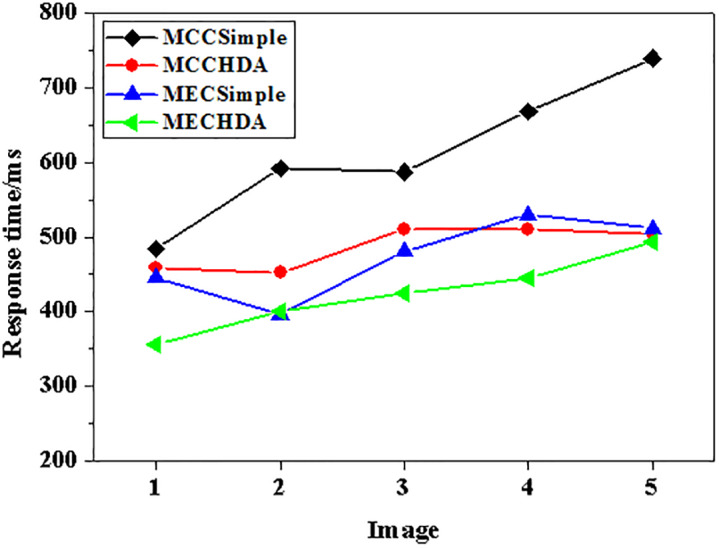
Response times for each architecture under WiFi.